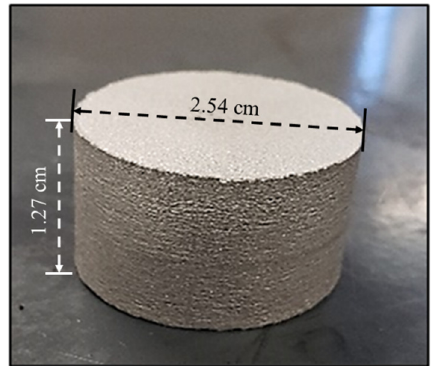
Figure 3. Manufactured Al-3Mg SPS component.